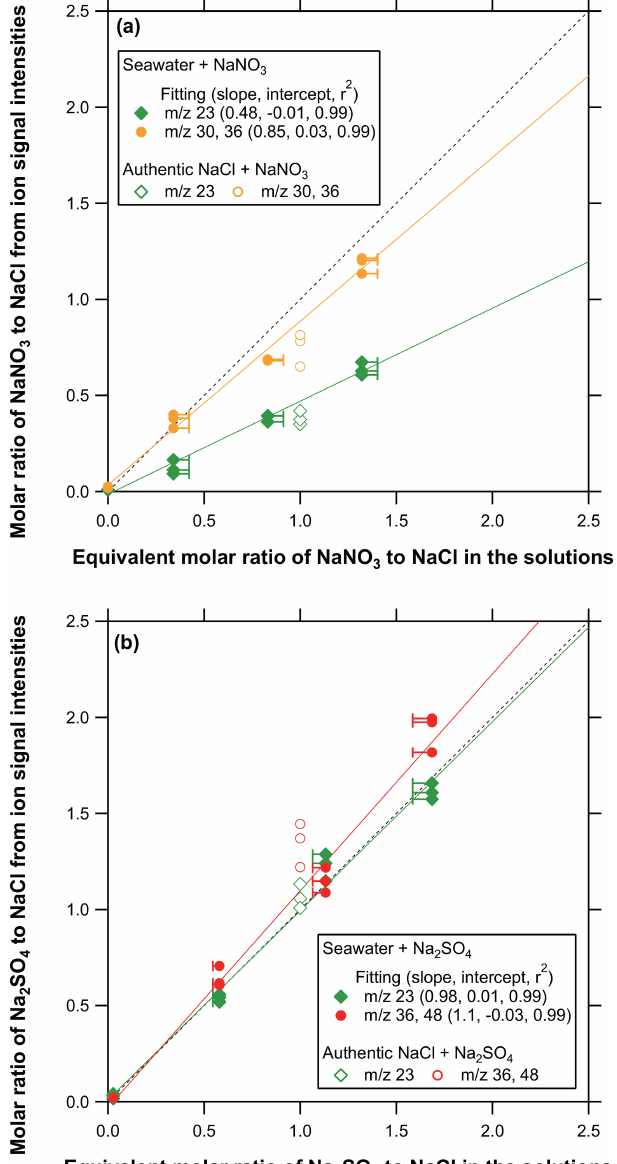
Figure 6. (a) Scatterplots of the molar ratios of SN to SC derived from ion signals versus the equivalent molar ratios of SN to SC in the solutions. The slope, intercept, and r 2 values for the linear regression are indicated in the legend. Solid and open symbols rep- resent the data from seawater + SN and SC + SN particles, respec- tively. The error bars for the x axis represent the uncertainties in estimating the equivalent molar concentrations of the compounds (see the Supplement for details). (b) Same as (a) but for the molar ratios of SS to